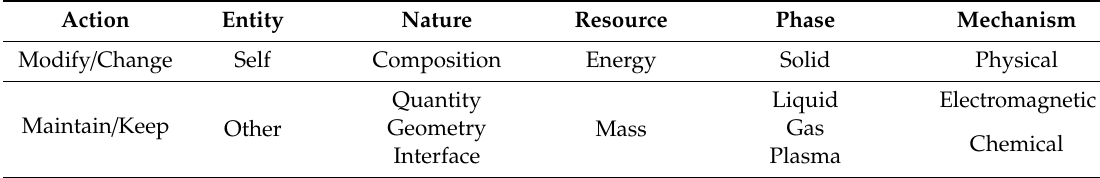
Table 5. Abstracted taxonomic building